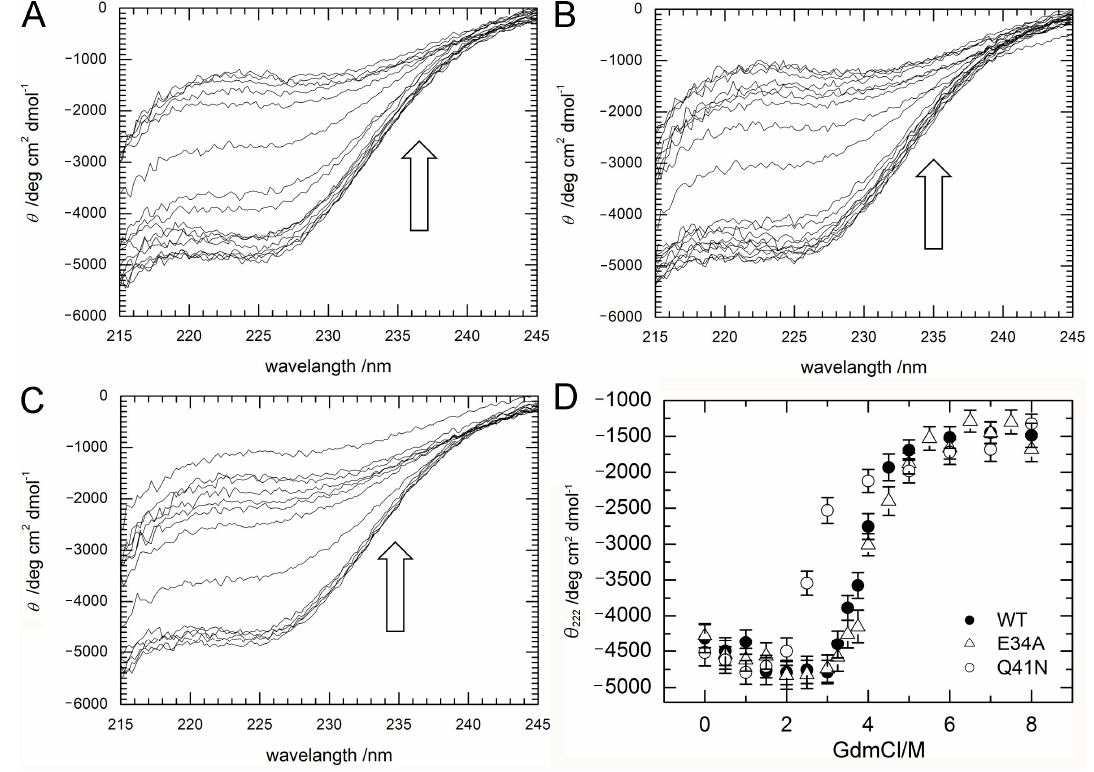
Figure 3. ( A – C ) CD spectra ( A ; WT; B ; E34A, C ; Q41N) and ( D ) molar ellipticity, θ 222 of WT (closed circles) and mutant (E34A; open triangles and Q41N; open circles) ubiquitin as a function of guanidine hydrochloride concentration. CD spectral changes by increasing a concentration of GdmCl are indicated by arrows ( ). Molar ellipticity was calculated from CD absorption at 222 nm (see Materials and Methods). Error-bars show root mean square deviation from the average.